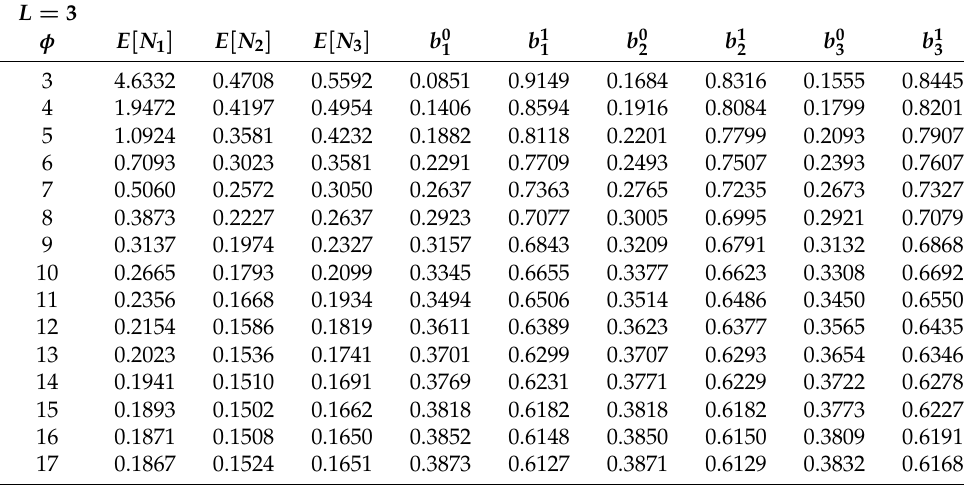
Table 6. Effect of φ on various performance measures ( L = 3).